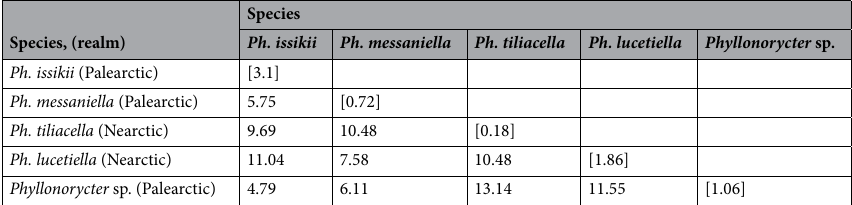
Overall, 32 haplotypes were found among 50 sequenced archival specimens of Ph. issikii (Figs. 6, 7, Tables S5, S6). All of them were detected in East Asia, including six which were shared with the West (H1, H2, H8, H13, (Figs. 6, 7). Notably, both haplotypes H1 and H23 are thought to be responsible for the invasion of the West- ern Palearctic dominating in the modern populations of Ph. issikii and widely found both in the Eastern and Western Palearctic 20 . Based on the analysis of archival herbaria, the haplotypes H13 and H23 were for the first time detected in the RFE and H22 in China, and the presence of the most distributed invasive haplotype H1 was confirmed by historical material from Japan and the RFE (Table S5) suggesting the contribution of Russia Far Eastern, Chinese and Japanese populations to the invasion of the moth westwards. Three haplotypes (H26, H28, H30) recorded in the archival Ph. issikii specimens from China and the RFE have been already known from East Asia through sequencing the insect specimens sampled in nature in twenty-first century, as per our recent study 20 (Table S5). In total, 23 out of 32 haplotypes were found for the first time and exclusively in archival specimens of Ph. issikii from East Asia (shown in circles with shading in Fig. 7, Table S6).